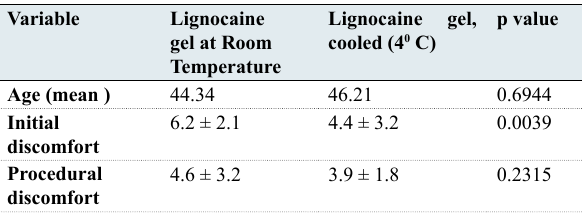
Table 1: Comparison of initial and procedural discomfort between lignocaine instilled at room temperature and cooled